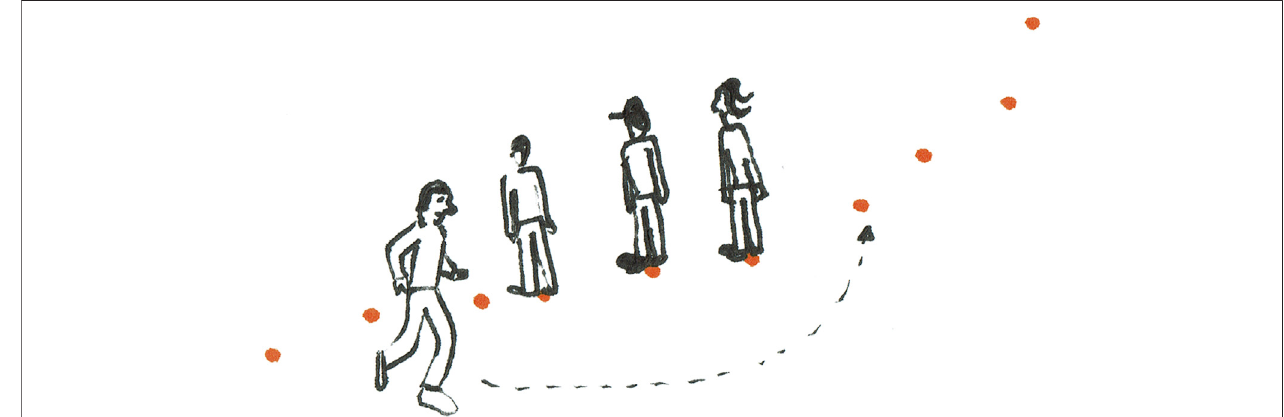
FIGURE 5 | Dynamic urban landscape.